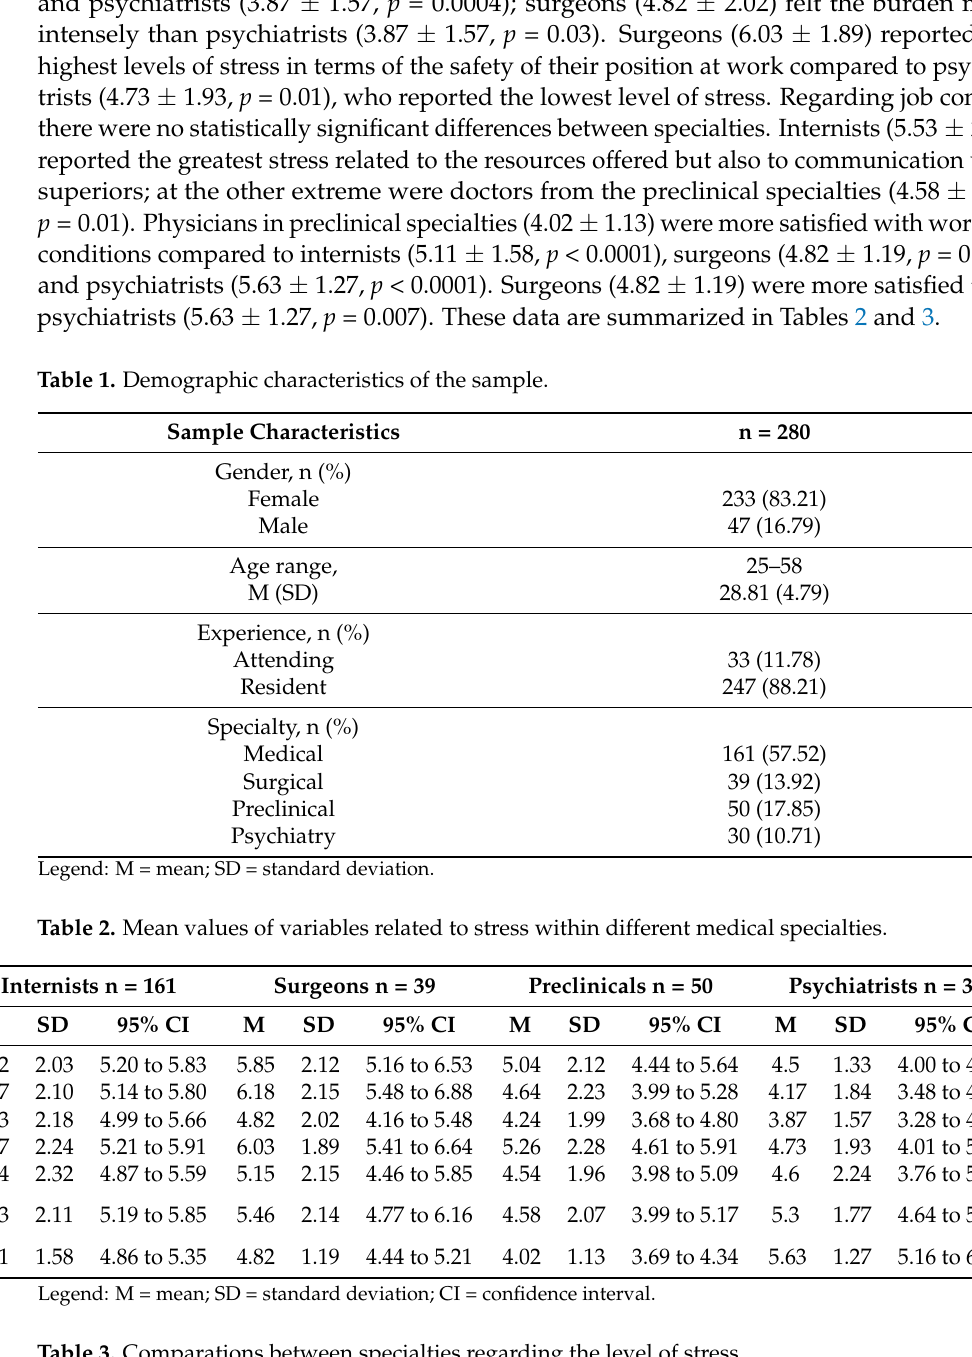
Table 3. Comparations between specialties regarding the level of